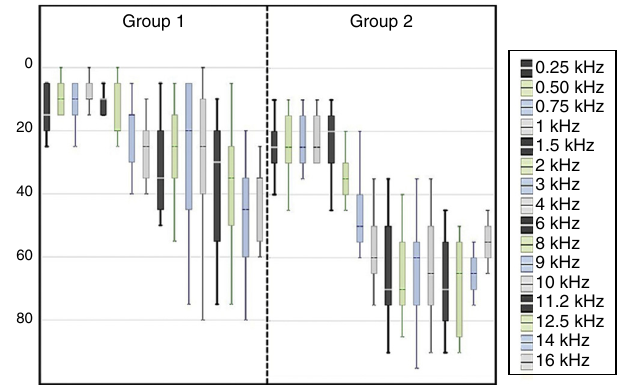
Figure 1 Values of mean, maximum and minimum audio- metric thresholds of the right ear (RE) in the stages initial assessment, monitoring and final assessment of the groups G1 and G2.